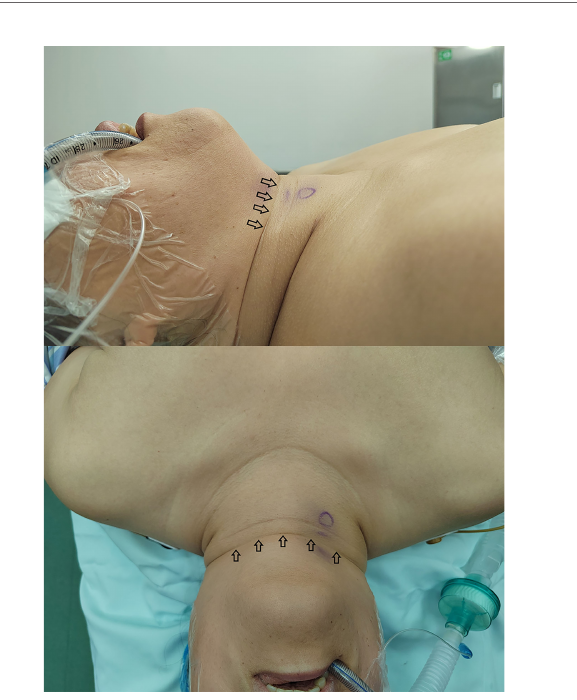
(A) Oral scar prior to modi fi cation of the vestibular incision. (B) Oral scar after modi fi cation of the vestibular